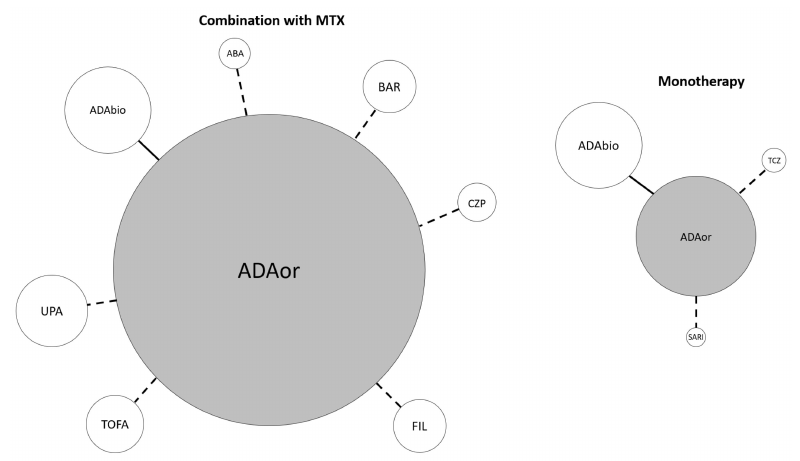
Figure 2. Mixed treatment comparison design. Reference treatment is